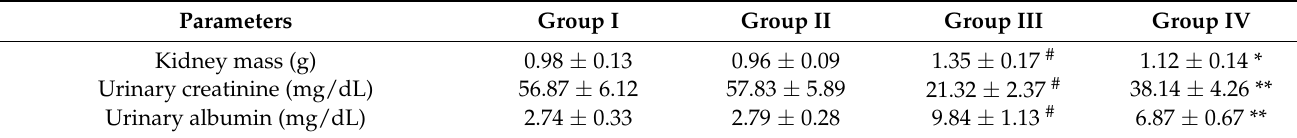
Figure 8. Effect of Myr on glucose uptake events by the skeletal muscle in T2D rats. ( a ) The immunoblot images showing effects of Myr in the expressions of signal proteins involved in glucose uptake by rat soleus muscle. ( b ) The graphs showing the densitometric analysis of immunoblots. Myr was able to improve glucose uptake by skeletal muscle by activating of PI3K expression, IRS1 phosphorylation, Akt phosphorylation, and GLUT4 translocation to membrane. The intensity of normal control band was assigned 1. β -actin served as the loading control for normalization. Data are expressed as mean ± SD ( n = 6). # Values significantly ( p < 0.01) differed from the normal control (T2D − ) group. ** Values significantly ( p < 0.01) differed from the diabetic control (T2D+) group. Table 2. Effect on kidney mass and renal function-related urine parameters.